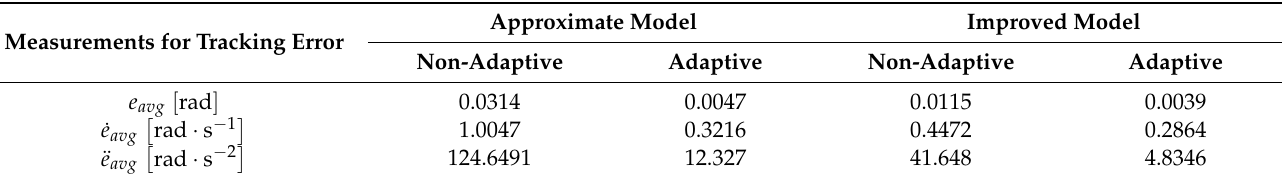
Table 2. Comparison of the various error